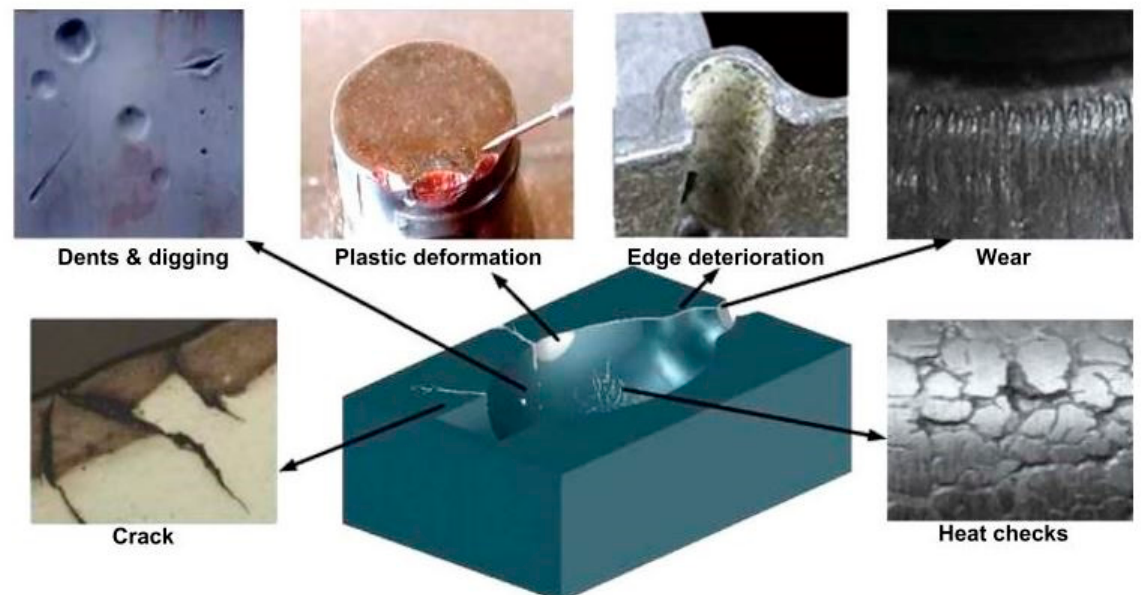
Figure 25. Defects in die and molds [174,175].